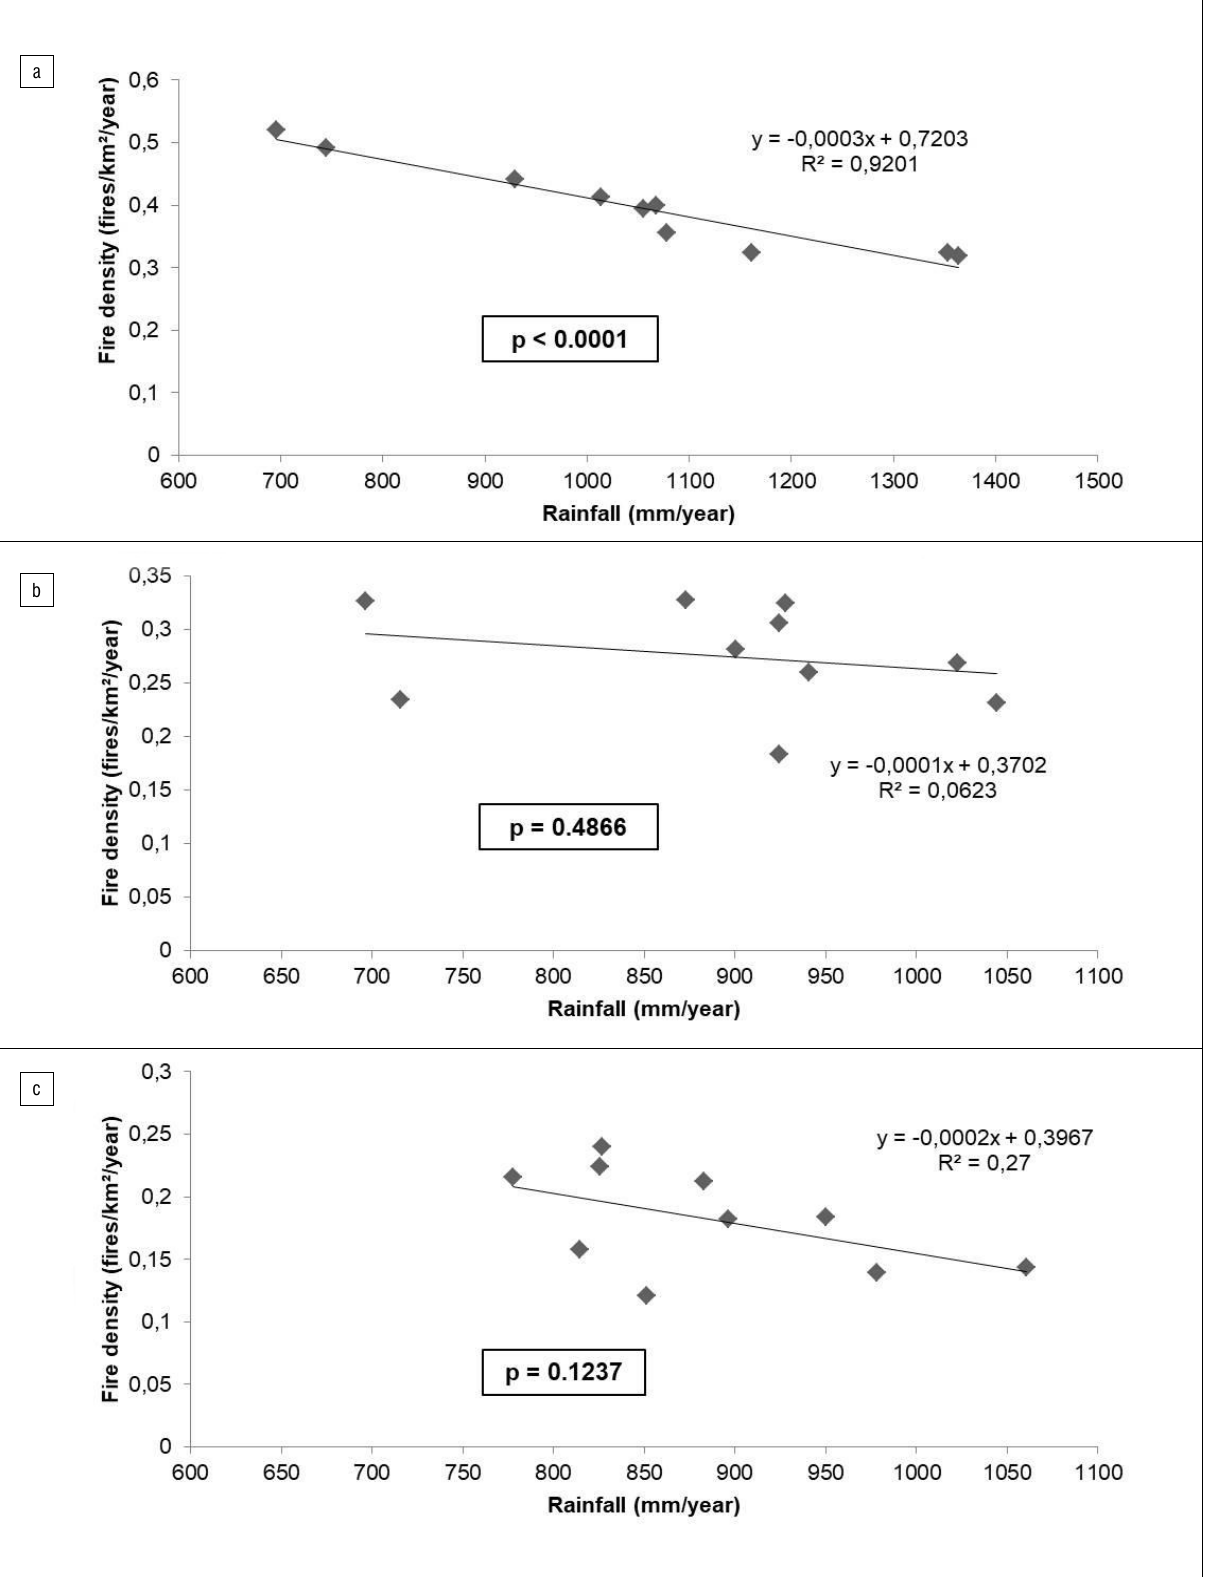
Figure 8: Synchronic variation of fire density relative to precipitation in the three main fire hotspots from 2007 to 2016. (a) Bafing, main region of the North- Western hotspot; (b) Bounkani, main region of the North-Eastern hotspot; (c) Hambol, main region of the Central